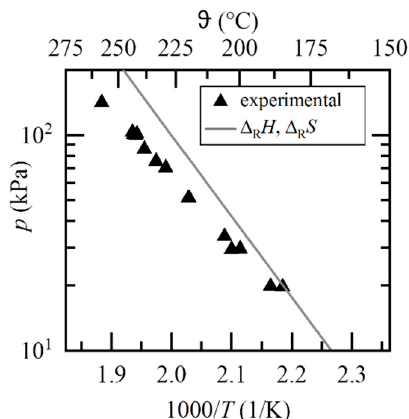
Figure 4. Van’t Ho ff plot for the hydration reaction: experimental data and correlation based Figure 4. Van’t Hoff plot for the hydration reaction: experimental data and correlation based on on thermodynamic data ( ∆ R H , ∆ R S calculated from literature data on enthalpy and entropy of thermodynamic data ( Δ R H , Δ R S calculated from literature data on enthalpy and entropy of formation formation [13]).